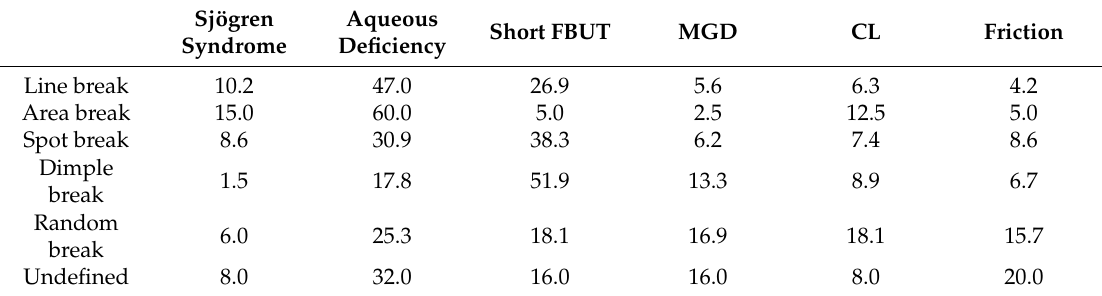
Table 2. Tear breakup patterns and dry eye